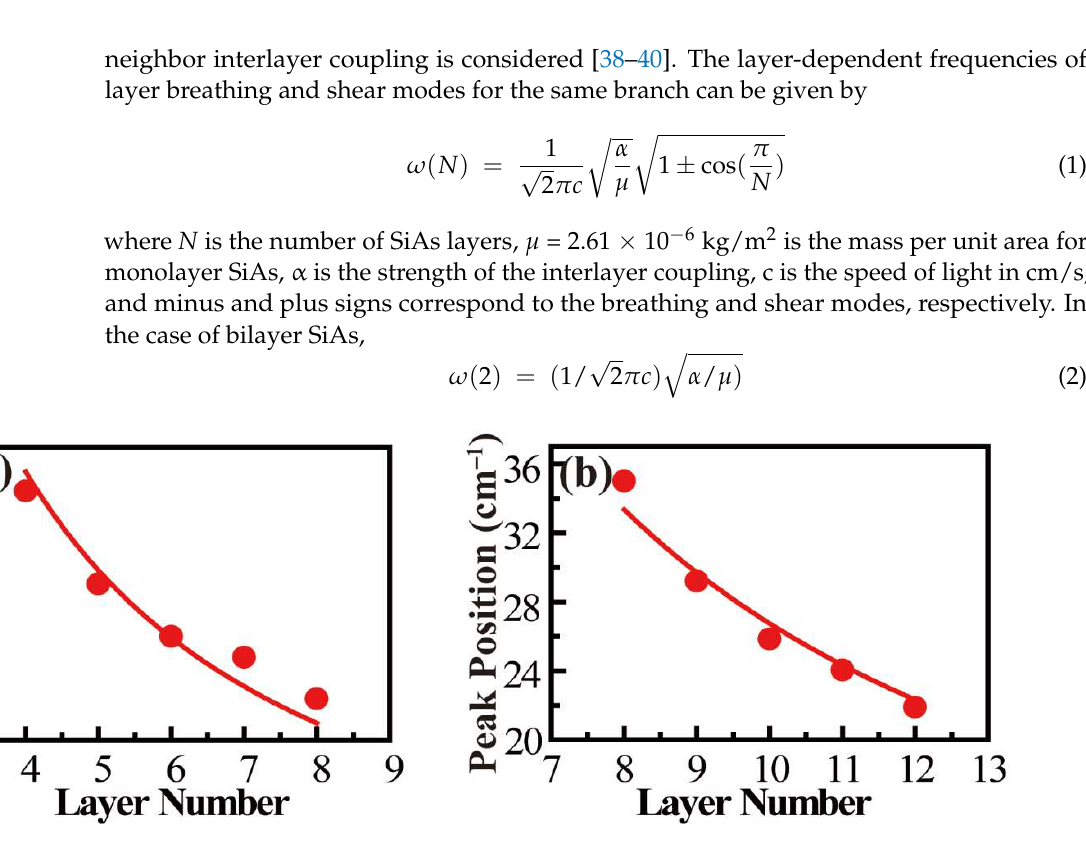
Figure 4. Fitting diagrams of two low wavenumber peak positions in the Raman spectrum with the obvious blue shift as the thickness decreases. ( a , b ) Trends in the positions of 16 cm –1 and 29 cm –1 fitted peaks of SiAs crystal with decreasing thickness.